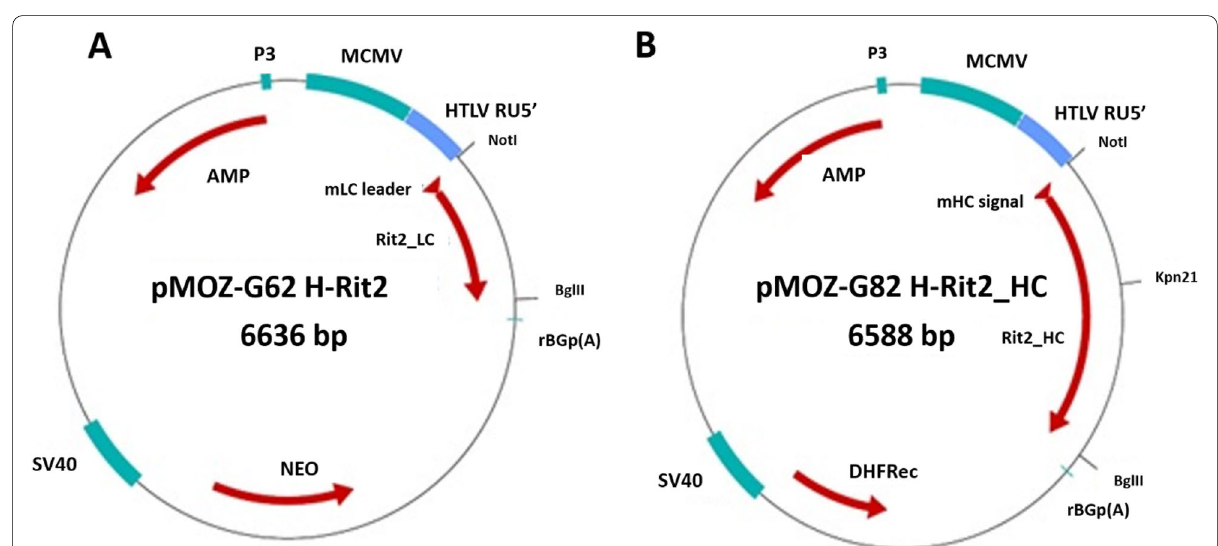
Fig. 1 Diagrams showing the expression vectors with the cloned light ( A ) and heavy chain ( B ) sequences. pMOZ-G62 carry neomycin resistance (NEO) gene as a dominant selectable marker. pMOZ-G82 vector contains a copy of the mouse dihydrofolate reductase (DHFR) gene under control of the SV40 early promoter. DHFR confers methotrexate resistance in Chinese hamster ovary cells (CHO) which lack dihydrofolate reductase. Both vectors carry mouse cytomegalovirus (MCMV) promotor elements and rabbit beta globin polyadenylation (rBGp(A)) signals